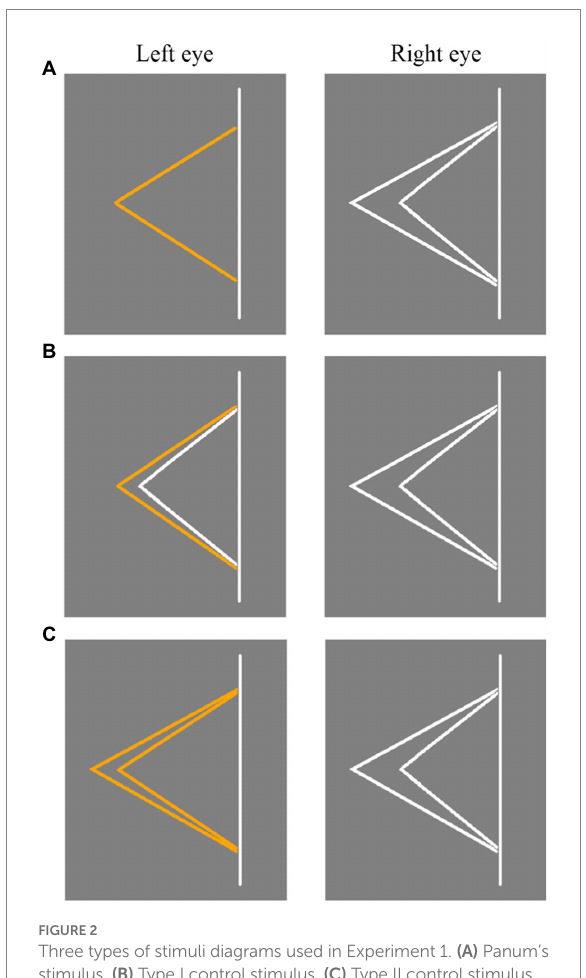
FIGURE 2 Three types of stimuli diagrams used in Experiment 1. (A) Panum’s stimulus. (B) Type I control stimulus. (C) Type II control stimulus. The stimulus presented to the left and right eyes was switched in different